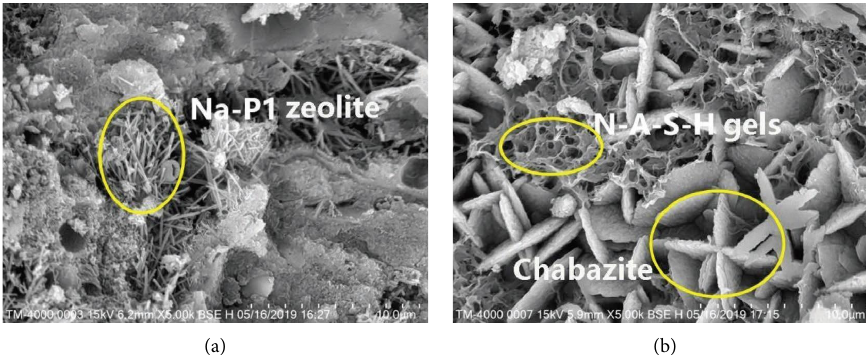
Figure 13: Te SEM images of fy ash/cement solidifed with diferent sodium nitrate concentrations after curing at 90 ° C for 28d are shown as follows: (a) 100g/L, 5%; (b) 500g/L, 5%.